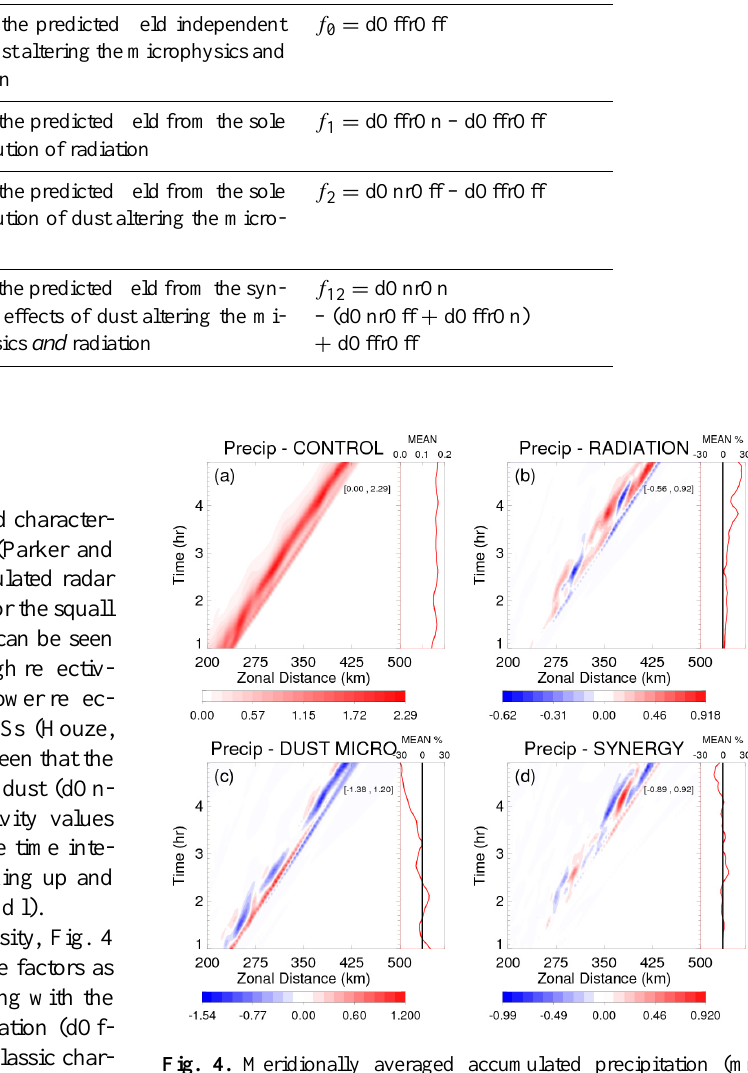
Fig. 4. Meridionally averaged accumulated precipitation (mm 5min − 1 ) for the four factors of (a) CONTROL, (b) RADIATION, (c) DUST MICRO, and (d) SYNERGY. See Tables 1 and 2 for fac- tor descriptions. The accumulated precipitation is expressed both as a Hovm¨oller diagram (shading) and a zonally averaged time series that is expressed as a percent contribution relative to CONTROL (line